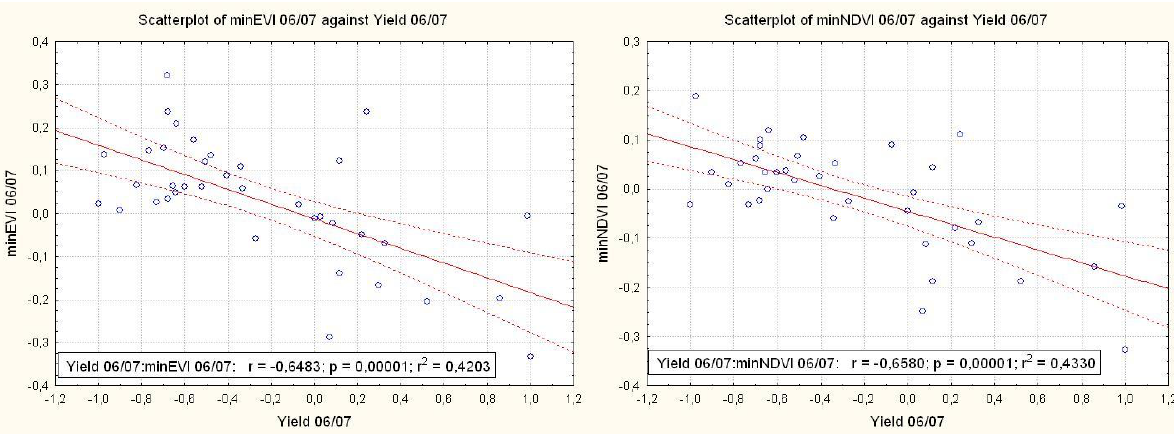
Figure 6. Correlation between variation on coffee yield and variation on minimum values of vegetation indices (minEVI and minNDVI) for the same year.